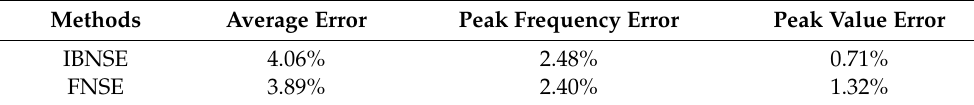
Table 3. Absorption coefficient errors corresponding to the FNSE and the IBNSE methods. Methods